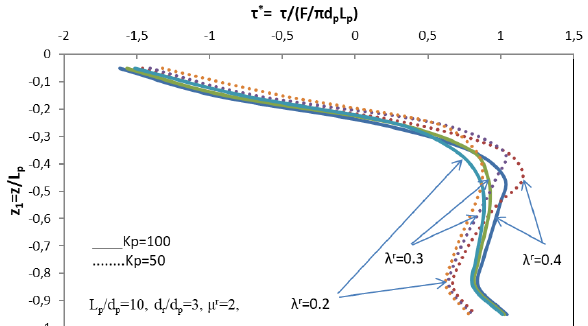
, with the normalized depth, r /d =10, d /d =3, μ r =4). p p r p